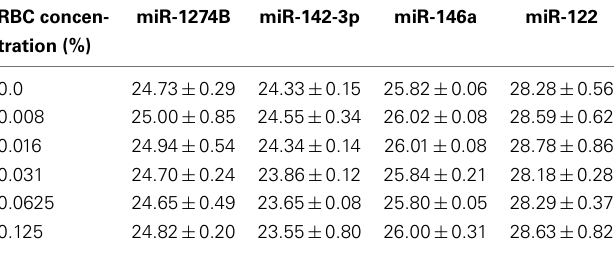
Table 3 | Cq values of stable miRs in dilution